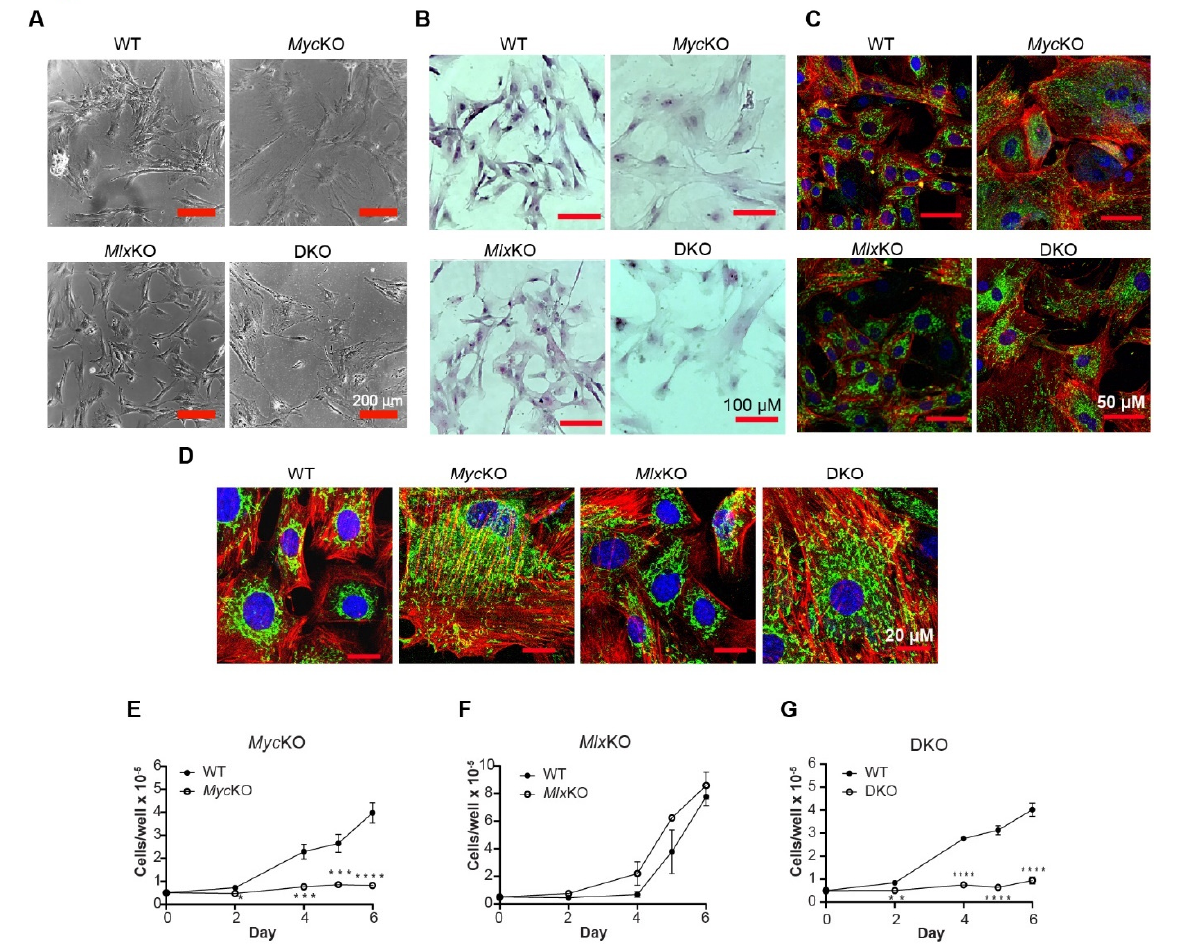
Figure 1. Morphological features and growth curves of MEFs: ( A ) Phase-contrast images of live, day 14 MEFs. ( B ) The same cells grown on coverslips, fixed, and stained with H & E. ( C ) Confocal micrographs of day 14 MEFs after staining of nuclei with Hoechst 33342, mitochondria with MitoTracker™ Green, and the cytoskeleton with Cell Mask Orange Actin Tracker. ( D ) Higher-magnification live confocal images of the indicated cells obtained on day 21, showing an apparent increase in mitochondrial mass in Myc KO and DKO MEFs (green). In A-D, red bars are included as sizing references as indicated in the rightmost/lower rightmost images ( E – G ) Growth curves of Myc KO ( E ), Mlx KO ( F ), and DKO MEFs ( G ), each performed in parallel with WT cells. All cells were plated in 4OHT-free medium on day 7. Each point represents the mean of three replicas ± 1 S.E. Significance was determined by multiple ratio paired t -tests; * p <0.1, ** p <0.01, *** p < 0.001, **** p < 0.0001.